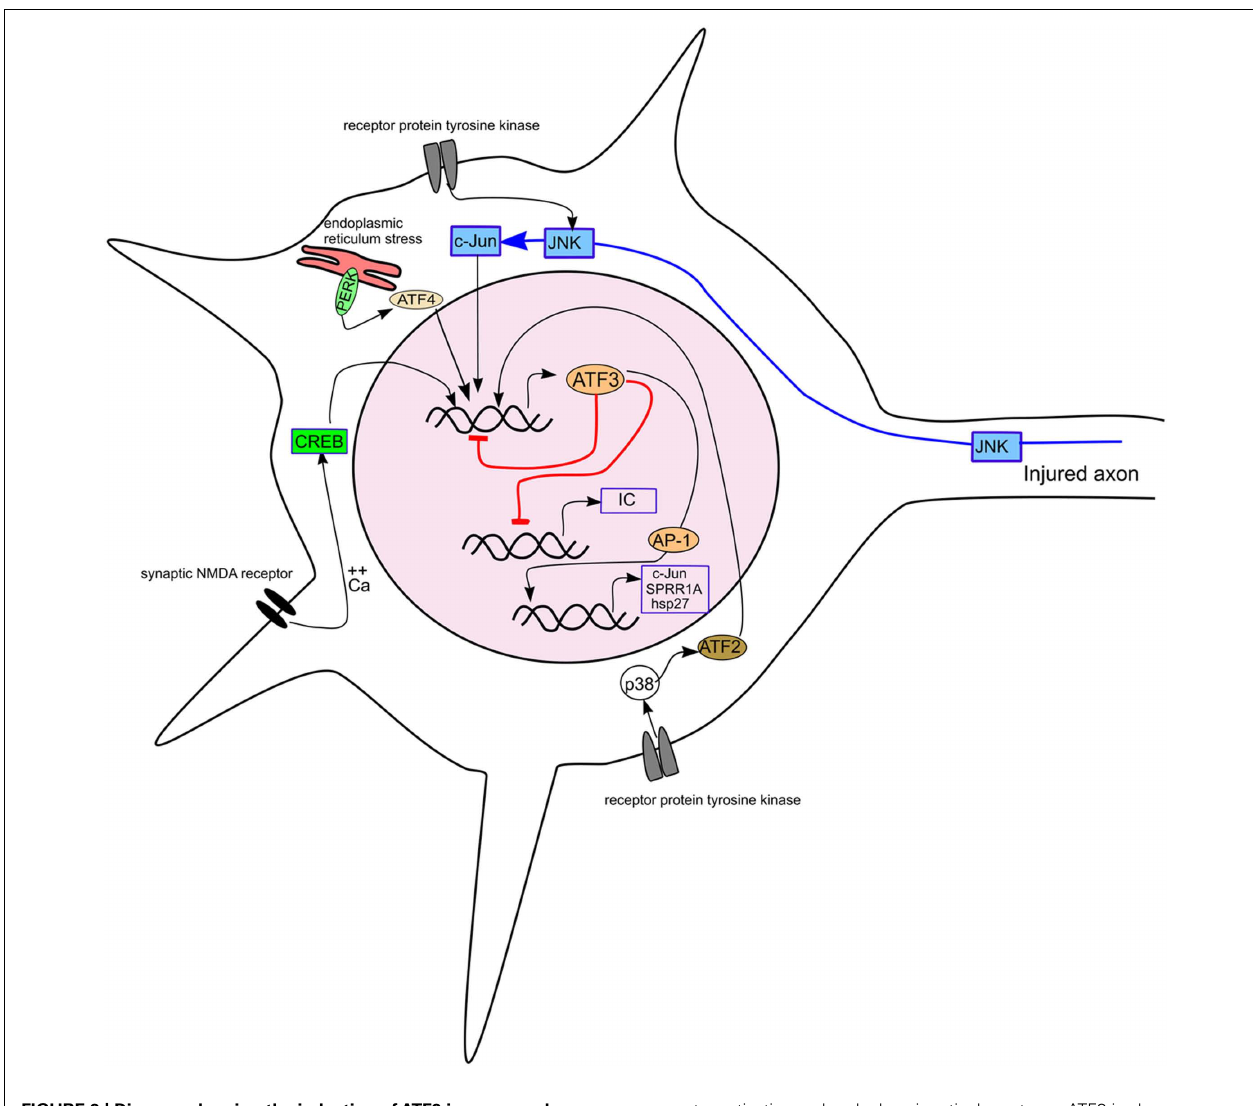
FIGURE 3 | Diagram showing the induction ofATF3 in a neuron by different stimuli and its effect on some targets relevant to axonal regeneration. The pathways inducing ATF3 expression include axotomy, receptor protein tyrosine kinase stimulation, synaptic NMDA